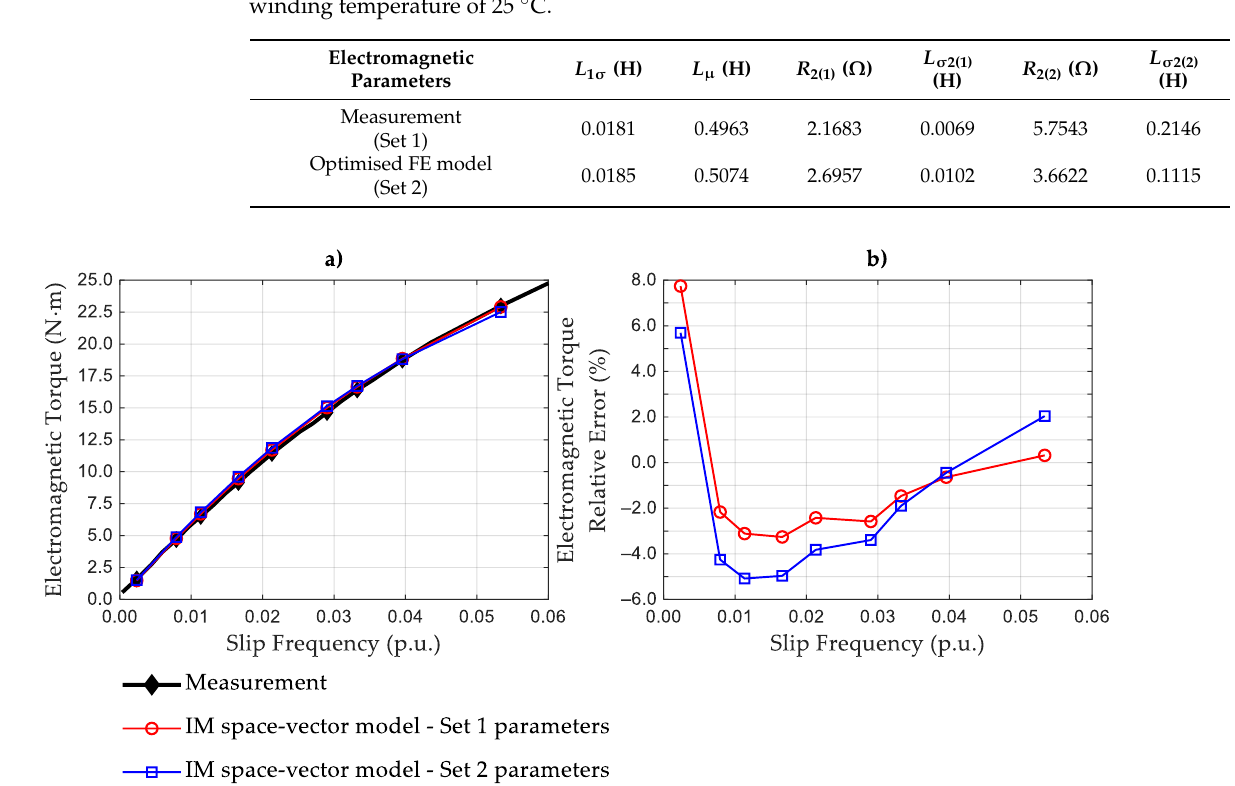
Figure 7. The torque-versus-slip frequency curves determined based on the data derived from the LCT performed experimentally and by means of the IM mathematical model: ( a ) torque-versus-slip frequency curves and ( b ) relative errors.